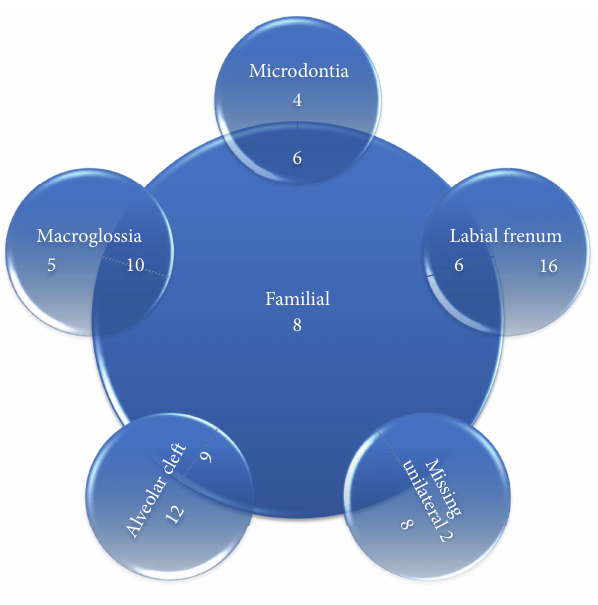
Figure 4: Intersecting circles chart depicting the common occur- rence between the major contributing factors.